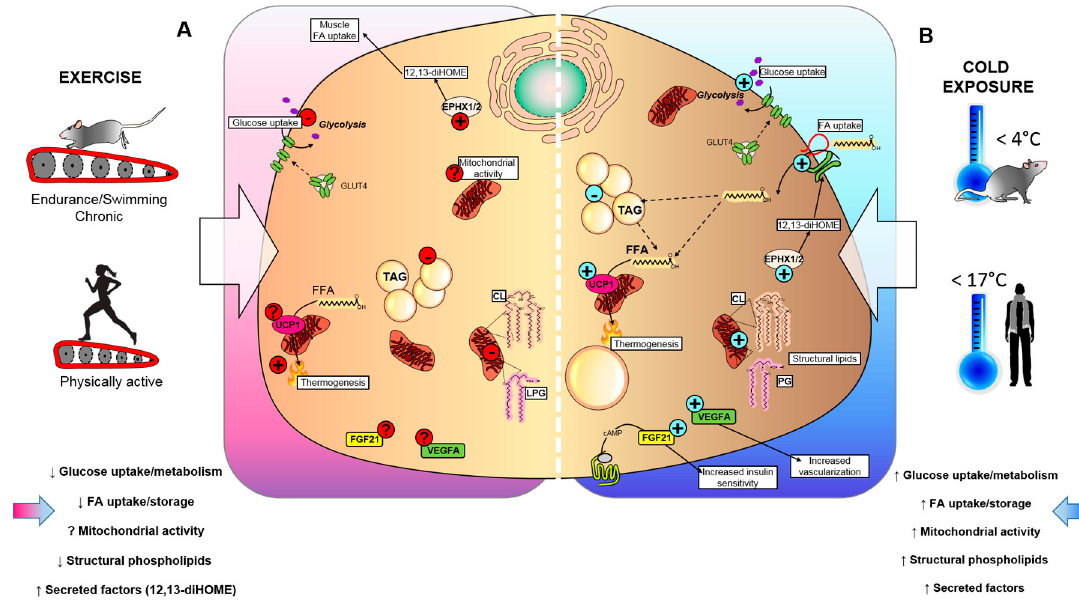
Figure 1. Effects of cold exposure and exercise on BAT. ( A ) Exercise and ( B ) cold exposure effects on BAT metabolism can cause the release of batokines, which act in an autocrine, paracrine, or endocrine manner to influence metabolic health. ( A ) Exercise reduces insulin-stimulated glucose uptake in BAT, suppresses triglyceride (TAG) accumulation, and lowers mitochondrial lipids, such as cardiolipin (CL) and lysophosphatidylglycerol (LPG), which could affect the thermogenic capacity of BAT. Conversely, exercise training stimulates epoxide hydrolase 1 and 2 (Ephx1/2), and increases the synthesis of the lipokine 12, 13-diHOME. The effects of exercise on mitochondrial activity, fibroblast growth factor 21 (FGF21) and vascular endothelial growth factor A (VEGFA) production are unknown. ( B ) Exposure to cold temperatures stimulates insulin-stimulated glucose uptake in BAT, synthesis of CL and LPG, and secretion of batokines FGF21 and VEGFA that lead to increased insulin sensitivity and tissue vascularization. Additionally, cold exposure increases the synthesis of 12, 13-diHOME, which can act in an autocrine manner to promote fatty acid uptake in BAT, ultimately leading to increased TAG and UCP1-mediated thermogenesis.